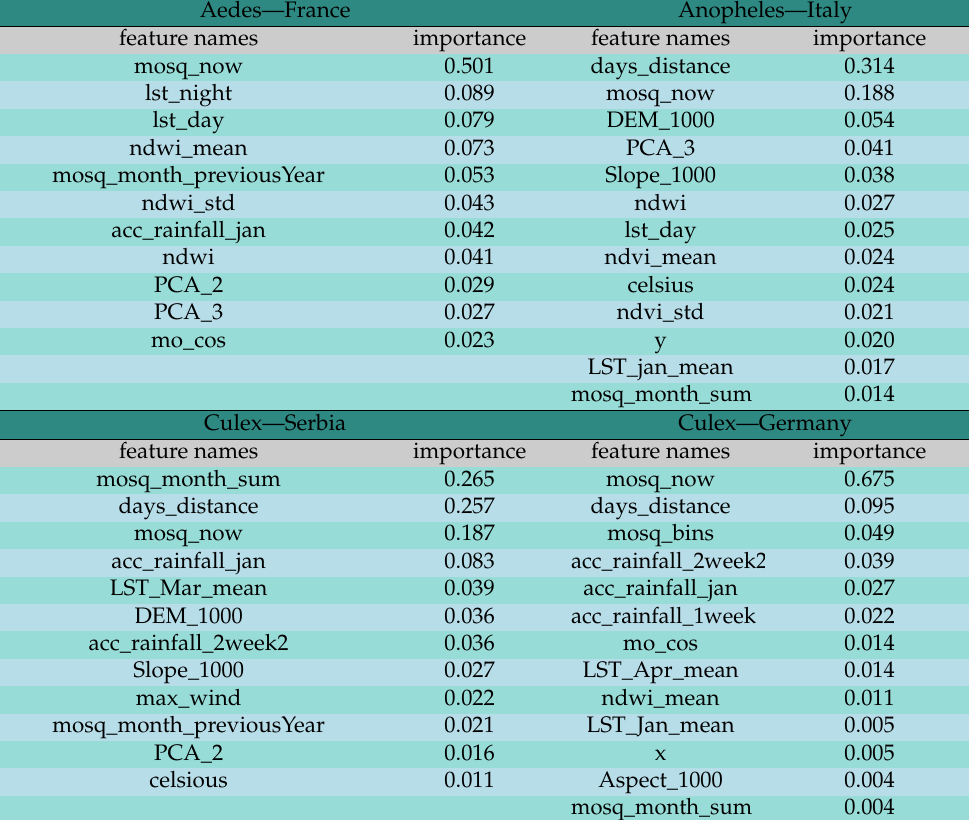
Table 4. Most important features per